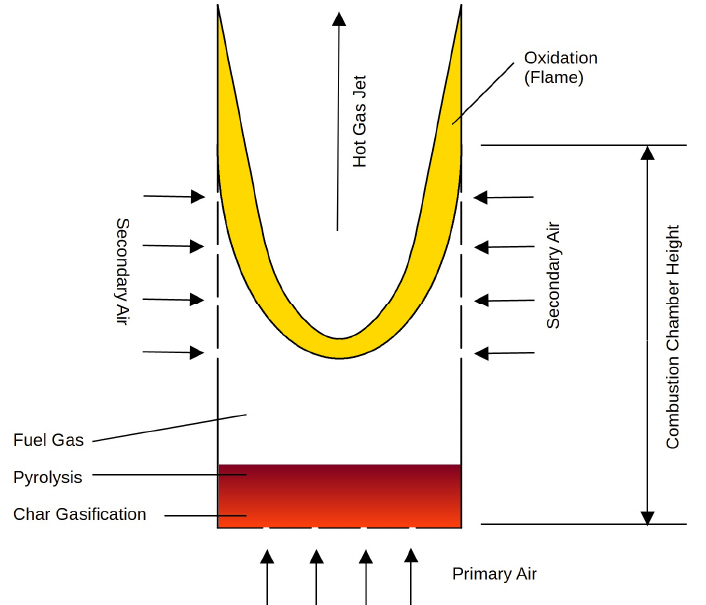
Figure 2. Graphical representation of the combustion process observed during the development and measurements of the Apeli stove.